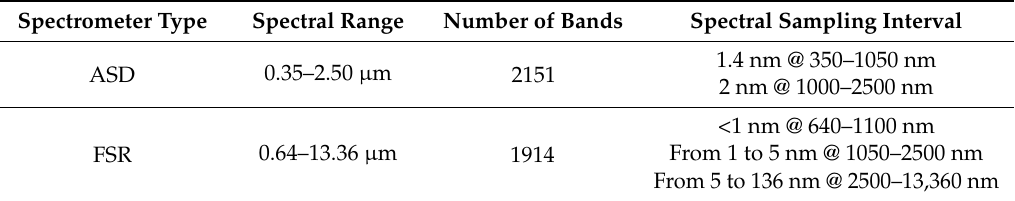
Figure 3. The spectra of the soil samples acquired from both spectrometers and the three tested scenarios are depicted ( a ) broad-band Full Spectral Range (FSR) reflectometer (spectral range of 0.64–13.36 µ m): Scenario 1 (Sc1) and Scenario 2 (Sc2) are depicted; ( b ) ASD FieldSpec 3 spectroradiometer (spectral range of 0.35–2.5 µ m), these spectral measurements represent Scenario 3 (Sc3); see the Section 2.3. for further details. Table 3. Technical specifications of the two spectrometers used.